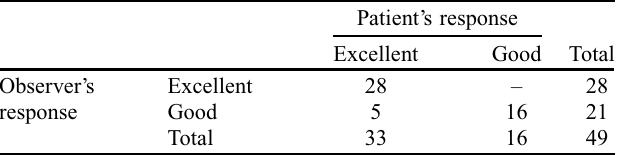
Table 1. Patient’s and observer’s response on role of